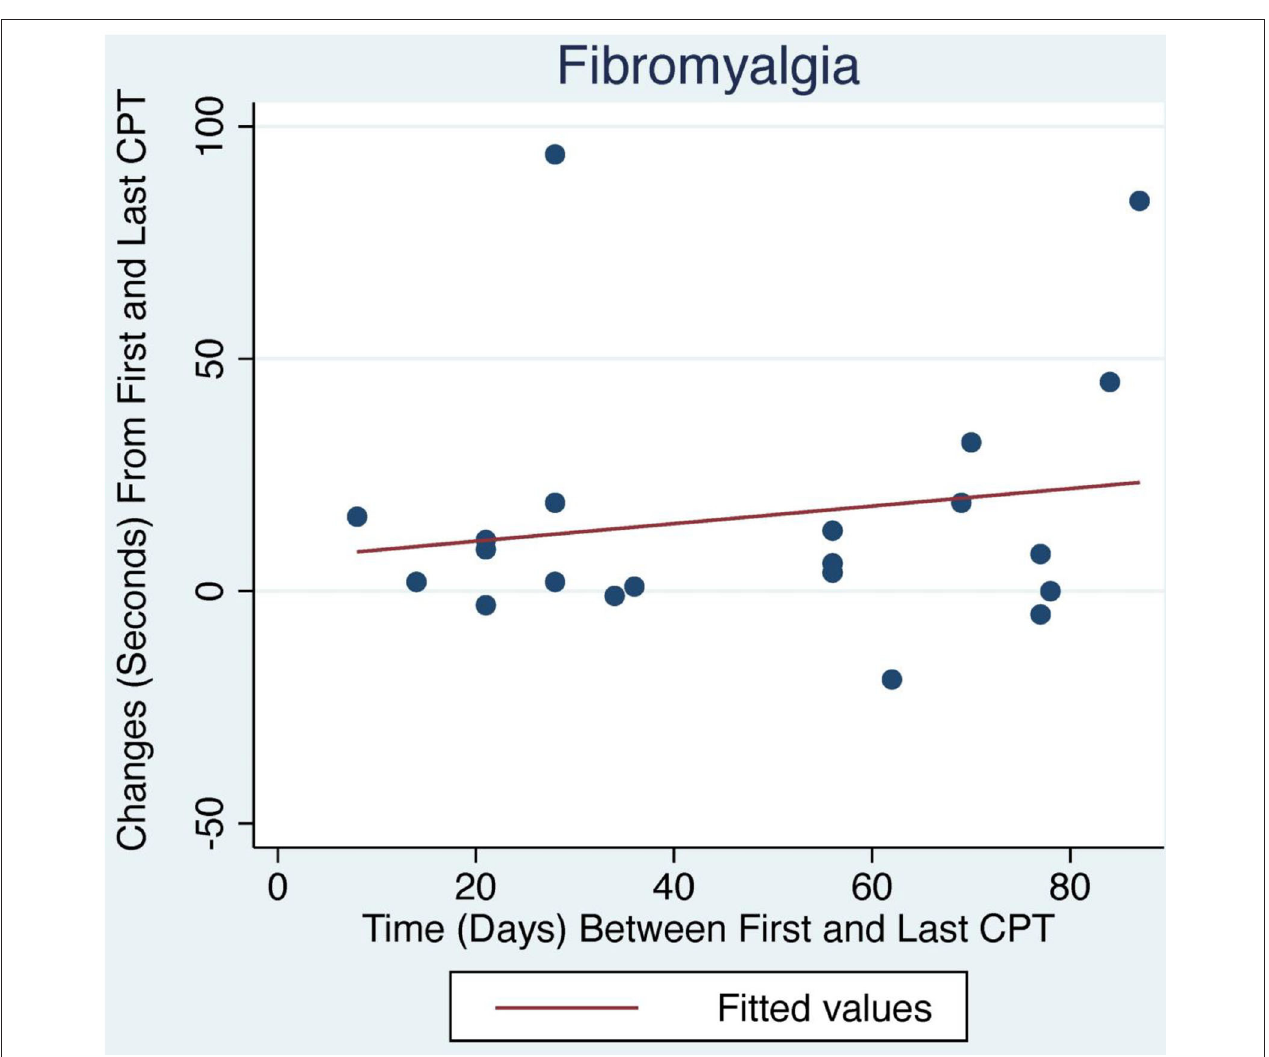
FIGURE 2 | Change in CPT over time with LDN treatment for FM patients. The relationship between change in CPT and number of days between first and last CPT measurement did not reach statistical significance.